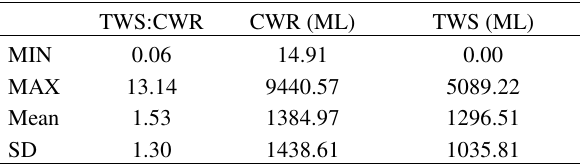
Table 2. Summary statistics of CWR and TWS, Jan-Apr 2009 (n =